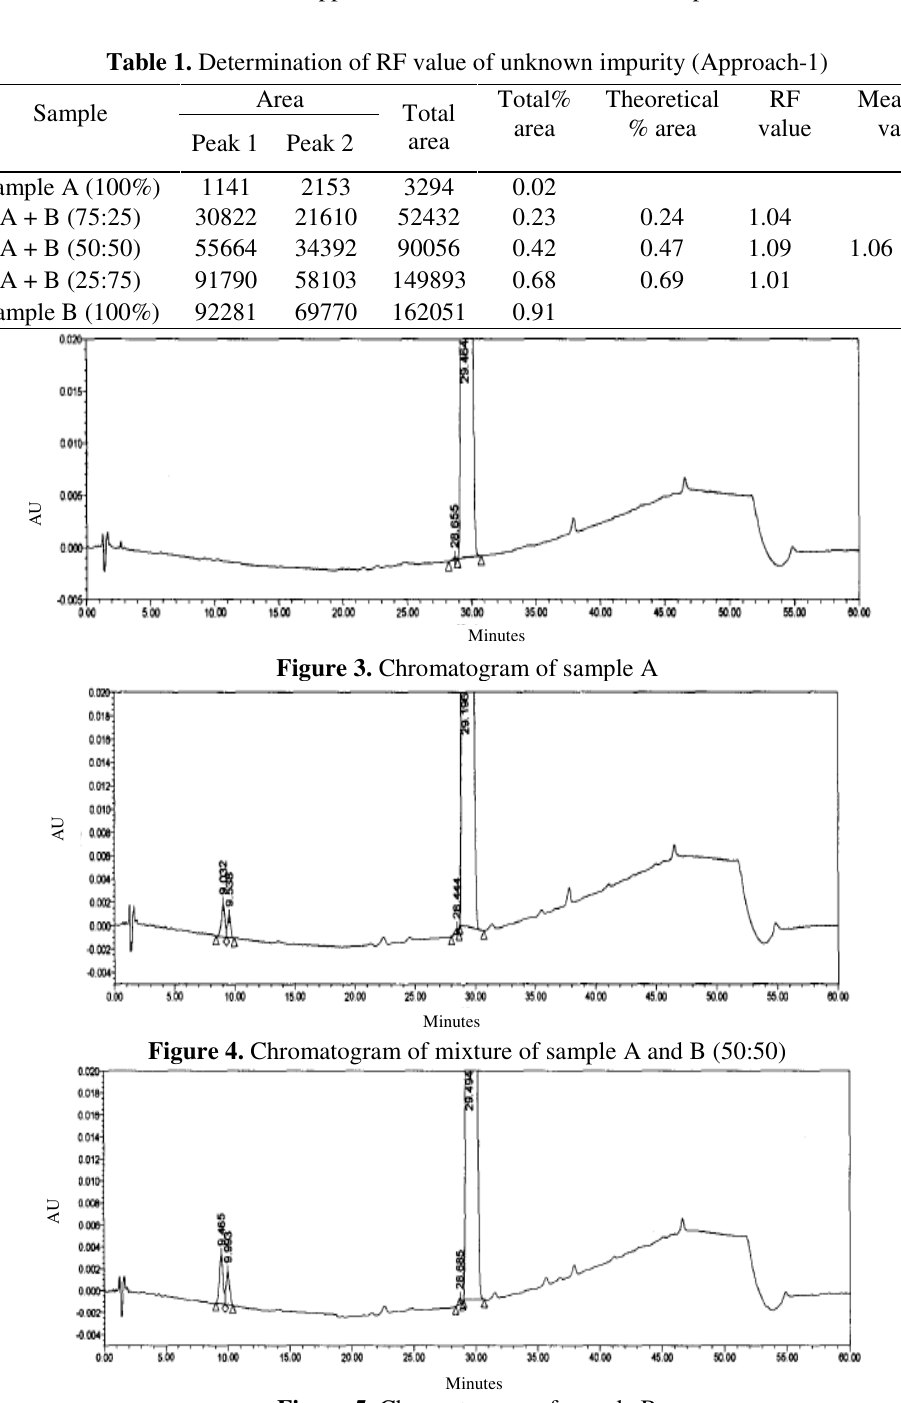
Figure 5. Chromatogram of sample